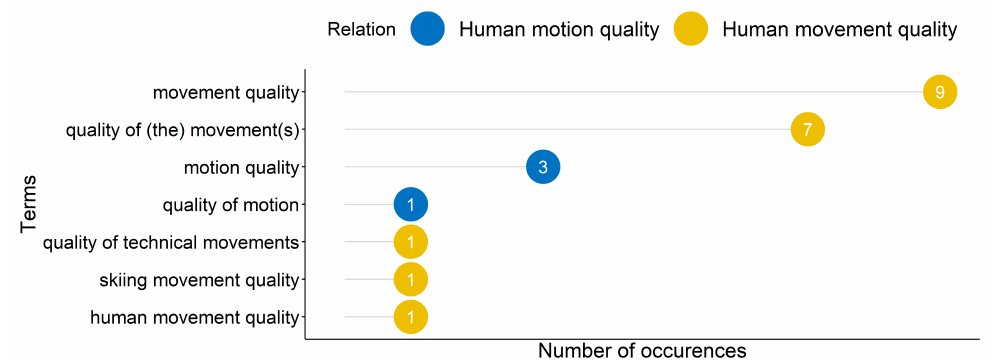
Figure 4. Representation of the most occurrences and alterations of the terms related to “human movement quality” and “human motion